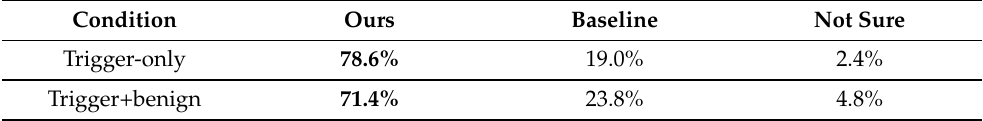
Table 3. Human evaluation results. “Trigger only” means only the text of the trigger sequence. “Trigger + benign” represents sentences where we connect triggers to natural text. “ours” means that our attacks are judged more natural, “baseline” means that the baseline attacks are judged more natural, and “not sure” means that the evaluator is not sure which is more natural.